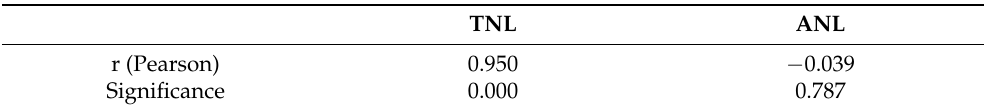
Table 1. Correlation analysis between the nighttime light index and CO 2 emissions. TNL, total nighttime light; ANL, average nighttime light.